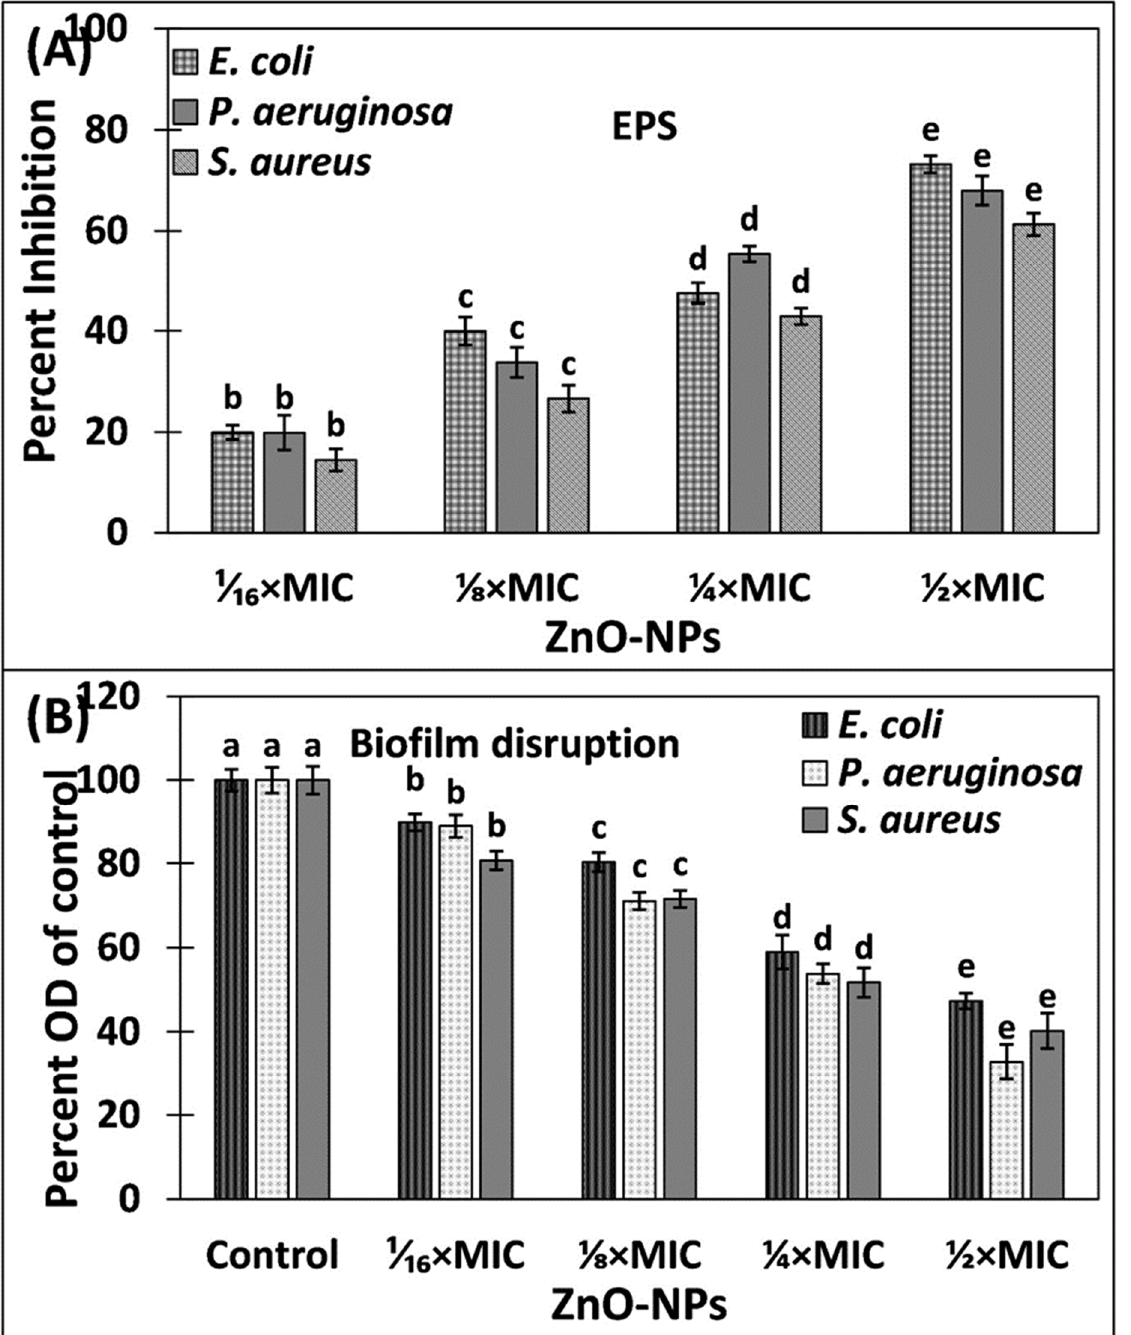
Figure 7. ( A ) Inhibition of EPS production in E. coli , P. aeruginosa , and S. aureus by ZnO-NPs. ( B ) Eradication of established biofilms of E. coli , P. aeruginosa , and S. aureus by ZnO-NPs. Data is presented as average of three replicates, and error bar is standard deviation. One-way ANOVA was performed using Tukey test at significance level of 0.05. Different letters in treatment groups represent different significance groups at p -value = 0.05 and are in ascending/descending order of values starting from the letter “a”.